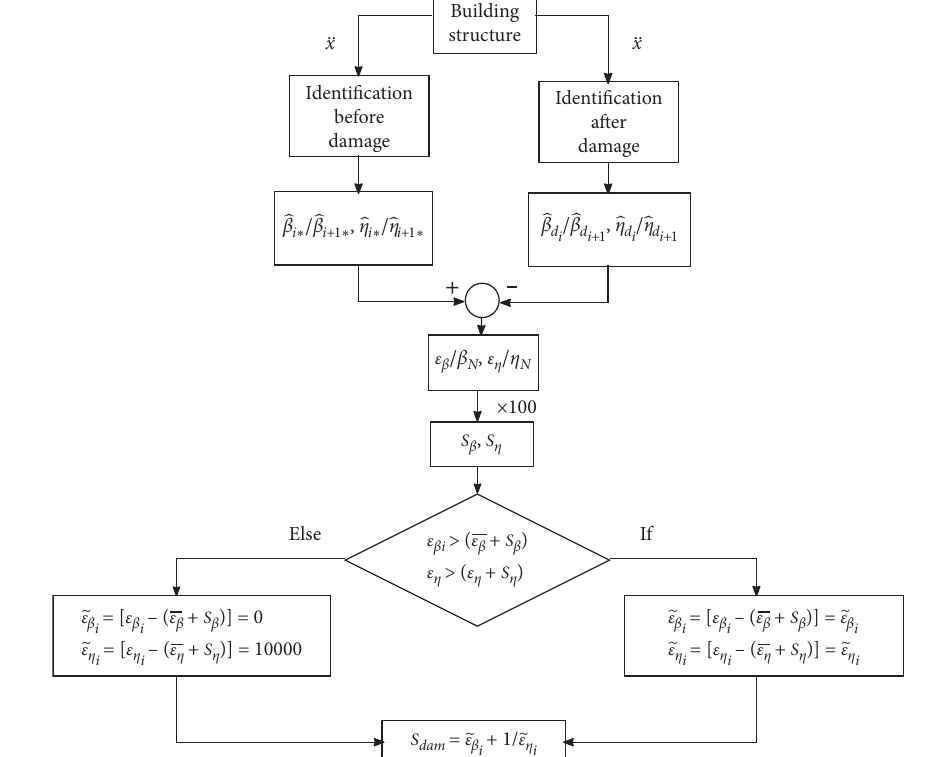
Figure 3: Scheme for damage location.